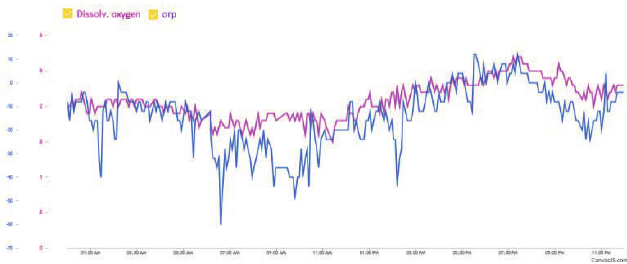
Fig. 11. The evident correlation between dissolved oxygen and ORP